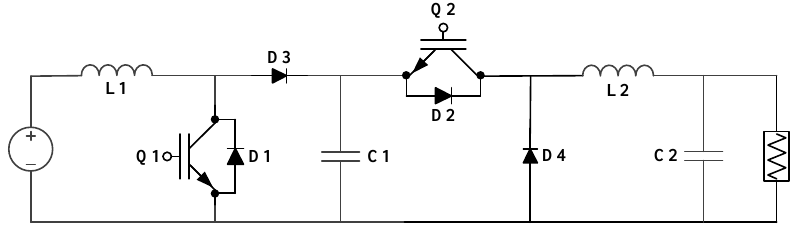
Figure 6. Circuit diagram of the Cuk converter.